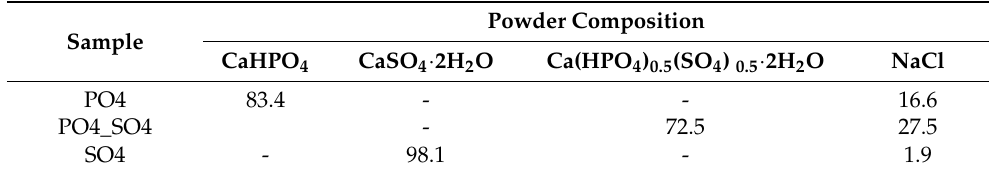
Table 3. Composition of synthesized powders after disaggregation, wt. %.